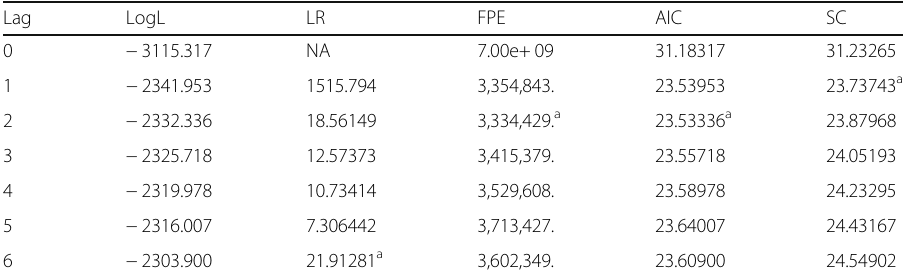
a indicates lag order selected by the criterion LR sequential modified LR test statistic (each test at 5% level) FPE Final prediction error AIC Akaike information criterion SC Schwarz information criterion HQ Hannan-Quinn information